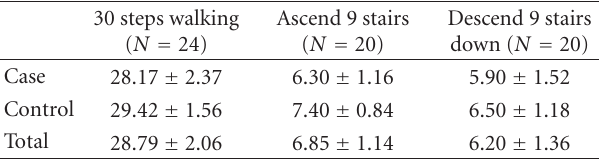
Table 4: Reliability of the IDEEA monitor for gait counts in walking on a flat and ascending or descending